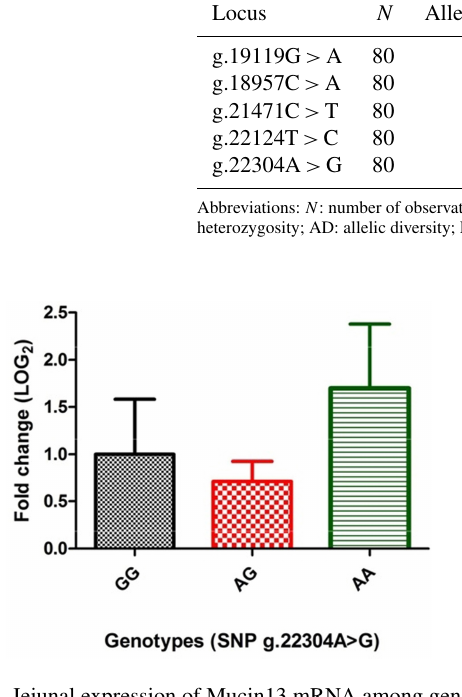
Figure 1. Jejunal expression of Mucin13 mRNA among genotypes of SNP g.22304A > G using quantitative